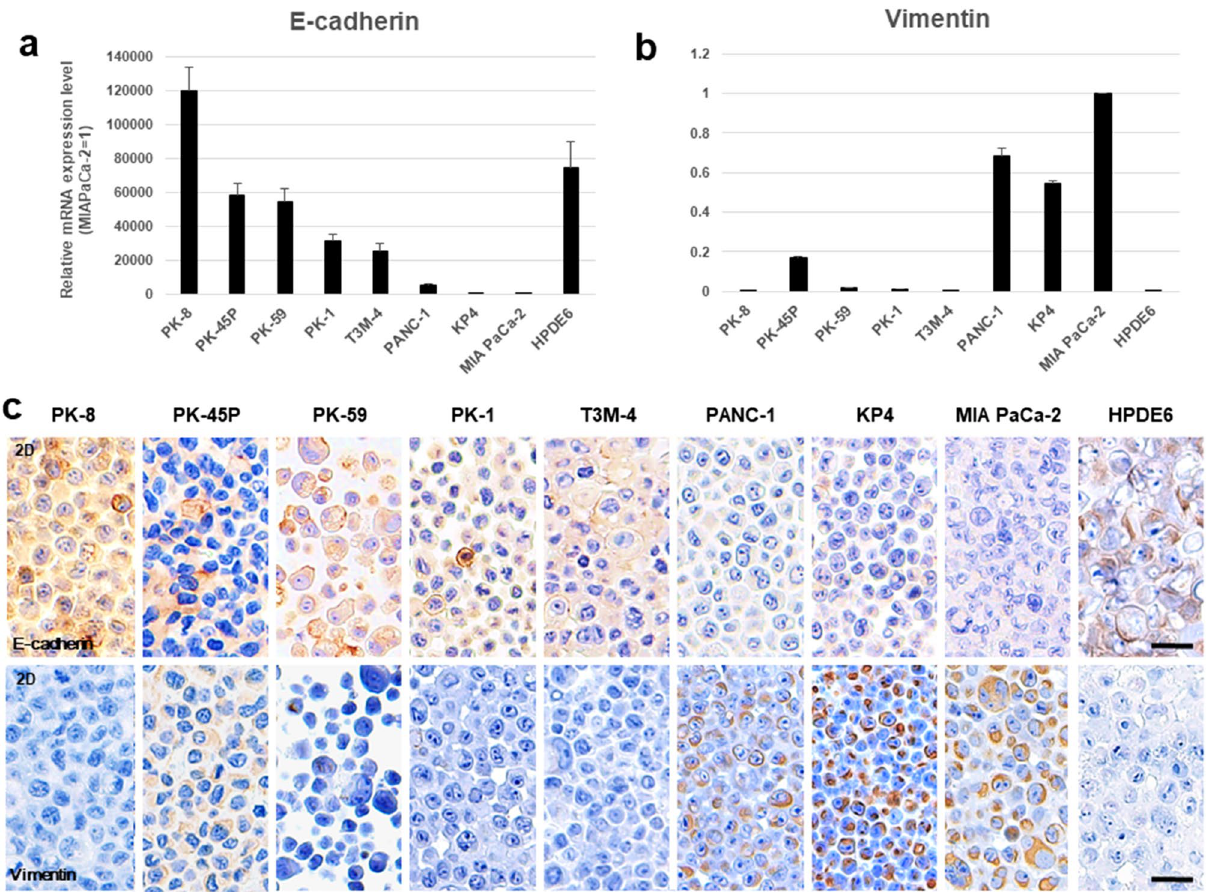
Figure 1. qRT-PCR and immunocytochemical analyses for PDAC cells in 2D culture. ( a ) E-cadherin and ( b ) vimentin mRNA levels were examined by qRT-PCR. There was high variability in the E-cadherin and vimentin levels. Results are presented as the means ± SD from triplicate measurements. The results are shown after normalization against the values obtained for MIA PaCa-2 cells (value = 1). ( c ) The expression levels